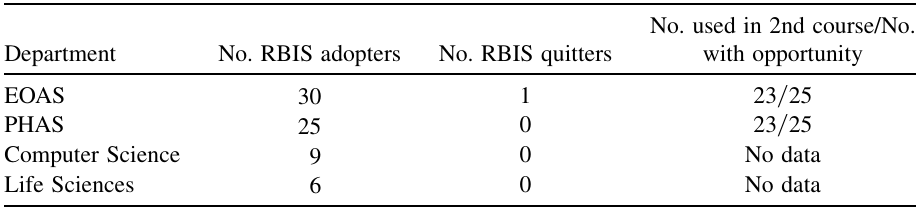
TABLE I. Number of faculty that adopted RBIS and number that adopted RBIS but sub- sequently quit using them, per the criteria defined in the text, and number of faculty that had the opportunity to use RBIS in additional course(s) and the number of those that did so, for EOAS and PHAS. Approximately 100 other faculty members have been involved with CWSEI teaching improvement efforts but did not meet the criteria for inclusion in these